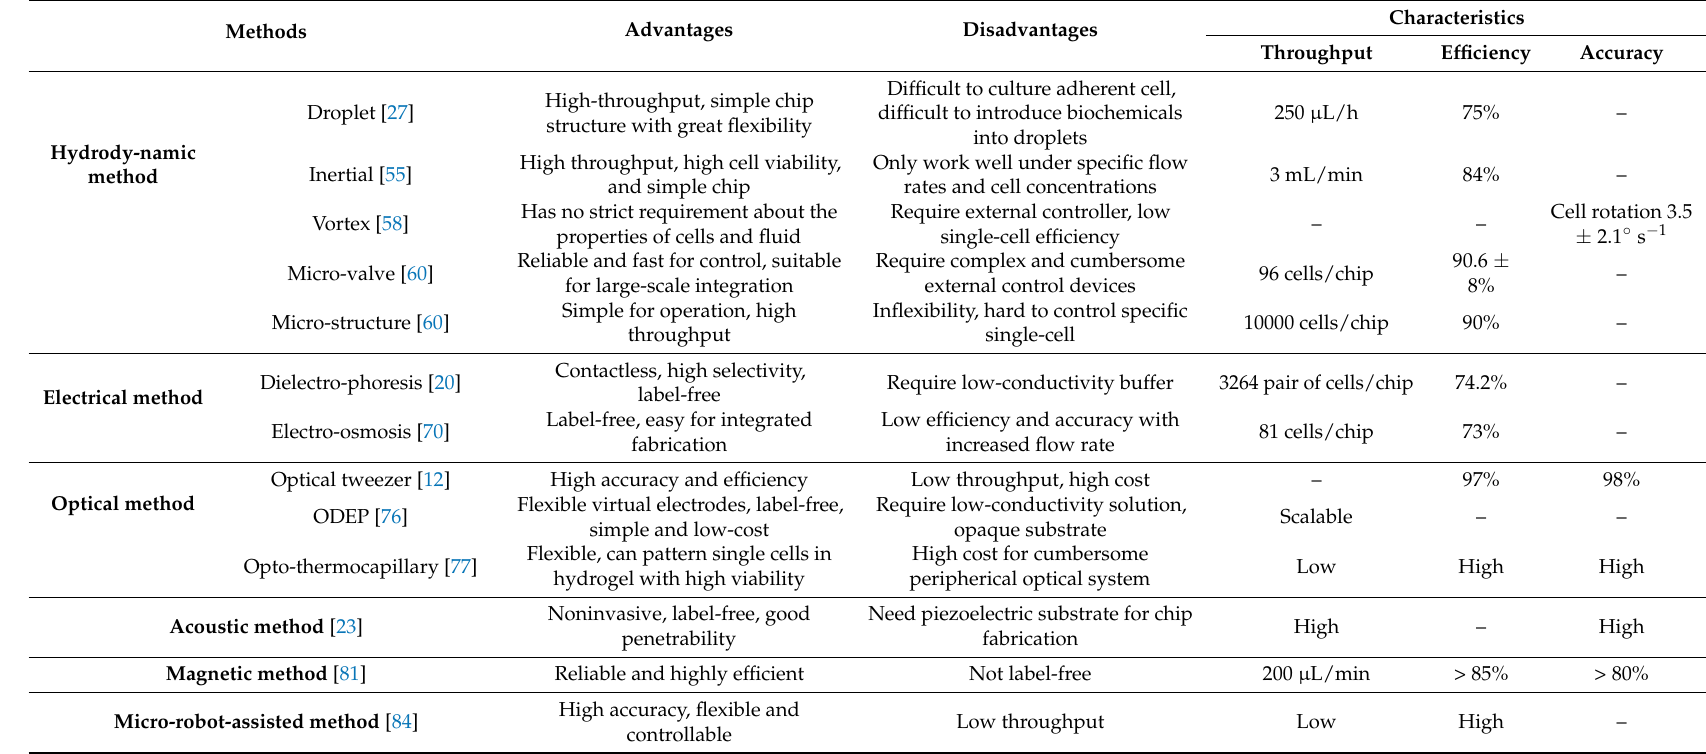
Table 2. Comparison of various methods for single-cell